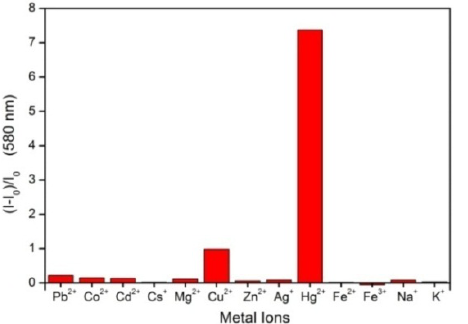
= 510 nm) in CH CN/H O ex 3 2